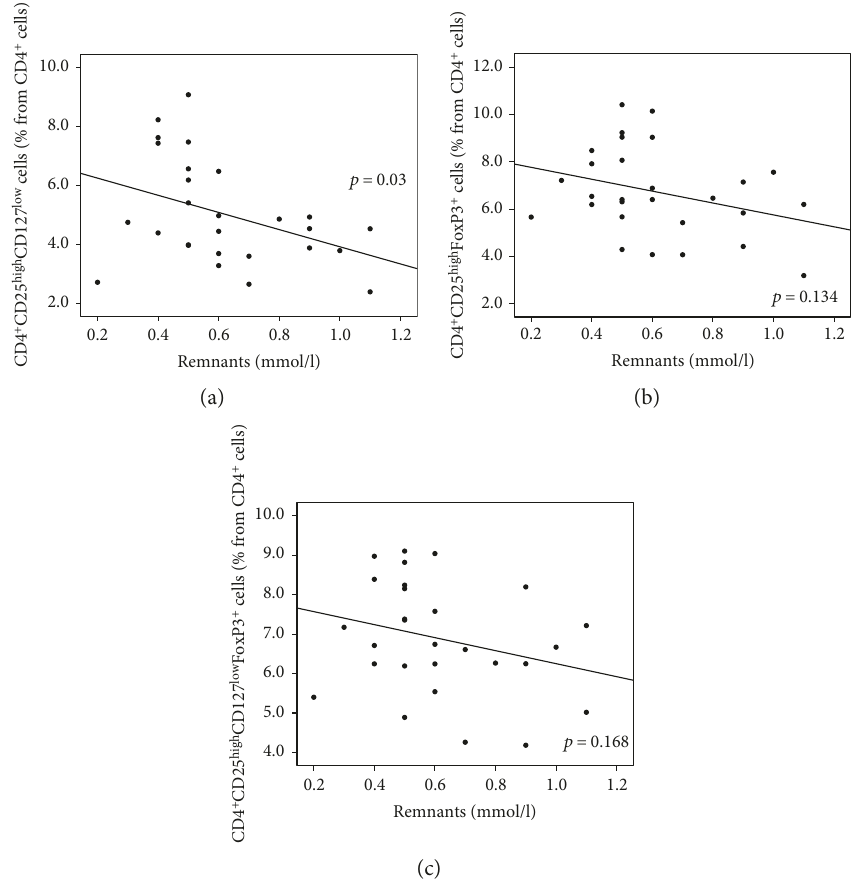
Figure 8: (a – c) The relationship between T regulatory cells and calculated “ remnant cholesterol ” . Higher calculated remnant cholesterol was correlated to lower Treg numbers. This correlation was signi fi cant in the case of CD127 low Treg cells ( p = 0 03 , R = − 0 418 ). The similar trend was observed for FoxP3 + as well as for CD127 low FoxP3 + Treg cells that failed to reach statistical signi fi cance ( p = 0 134 , R = − 0 29 and p = 0 168 , R = − 0 268 , resp.). (a) CD127 low Treg cells (% from CD4 + cells). (b) FoxP3 + Treg cells (% from CD4 + cells). (c) CD127 low FoxP3 + Treg cells (% from CD4 + cells).